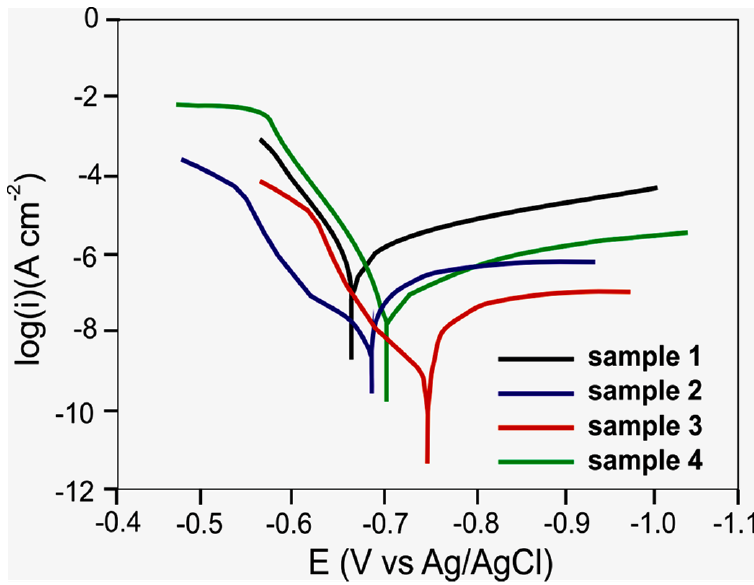
Figure 6. The polarization curves of samples 1–4 (Table 1) in O 2 -saturated 0.5 M NaCl obtained at a sweep rate of 1 mV/s.